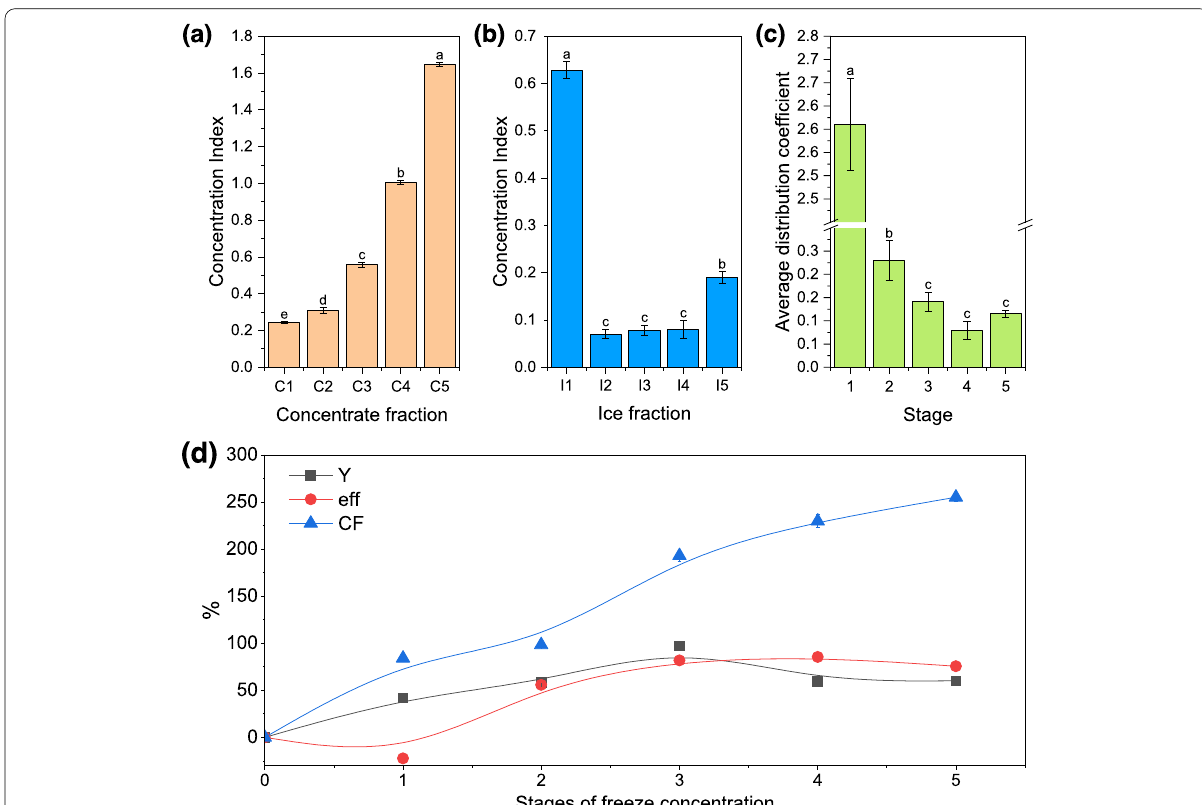
Fig. 4 Concentration index in concentrate ( a ) and ice ( b ) fractions, the average distribution coefficient ( c ), and the evolution of concentrate yield ( Y ), process efficiency ( eff ), and concentration factor (CF) based on total phenolics in block freeze concentration stages of pecan nut beverage ( d